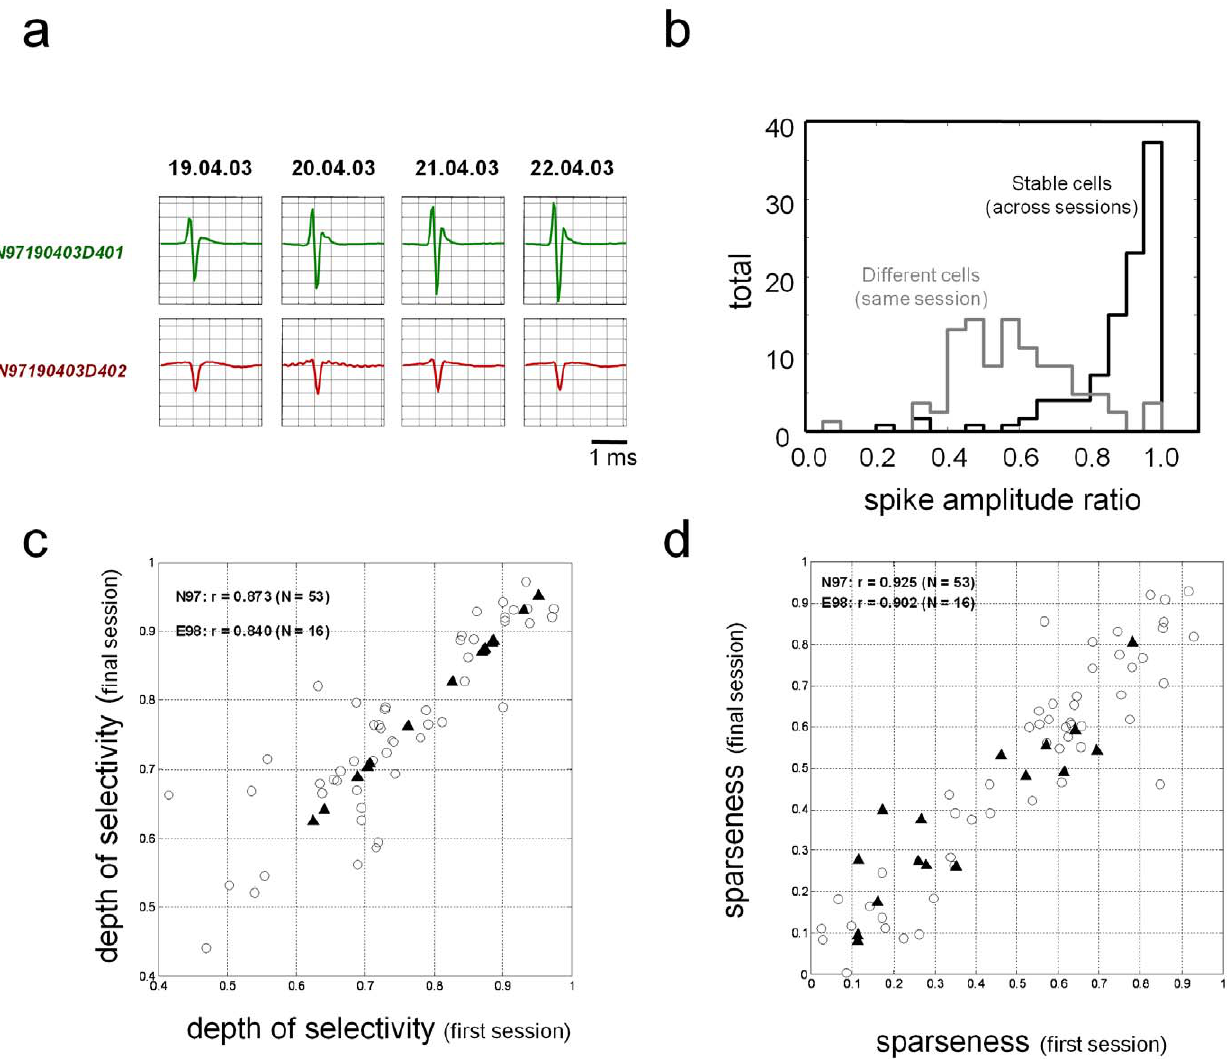
Figure 3. Waveforms remained similar between sessions. (a) The waveforms of the simultaneously recorded neurons shown in Figure 5 over the stable recording period. The basic shape remained similar, though the spike amplitude drifted over time. (b) Comparison in the ratio of the spike waveform amplitudes across the population (see Methods ). Stable neurons recorded across multiple sessions had amplitude ratios near 1.0, indicating that they did not change much over time. The amplitude ratio between different neurons recorded from the same session was generally much lower. (c) Correlation (r) in the depth of selectivity between the first and final sessions of all stably recorded neurons. Data shown separately for monkey N97 (open circles) and monkey E98 (black triangles) (d) Correlation (r) in the sparseness index between the first and final sessions of all stably recorded neurons.